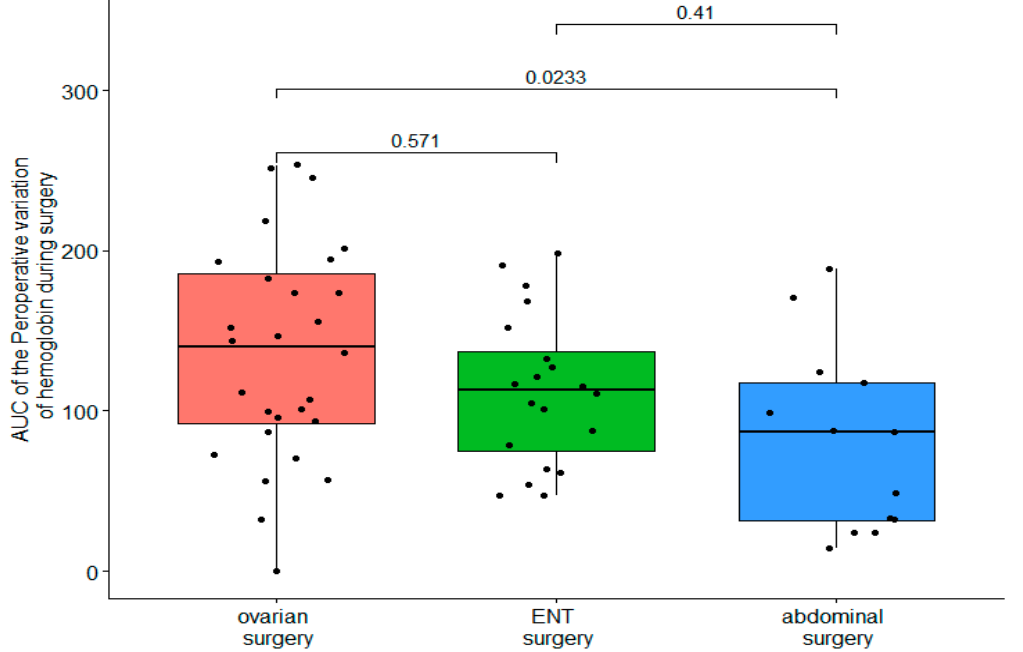
Figure 4. Comparison of the AUC of intraoperative variation of hemoglobin between surgery groups.